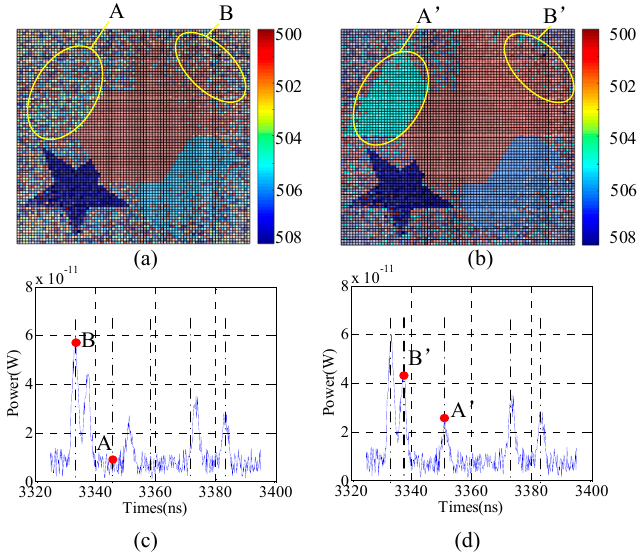
Figure 8 . Comparative results: ( a ) And ( b ) are 3DGI based on uniform time-slice method (UTSM) and NUTSM, respectively; ( c ) echo signals based on UTSM, with points A and B representing the corresponding positions of the time slices; and ( d ) echo signals based on NUTSM, with points A’ and B’ representing the corresponding positions of the time slices.